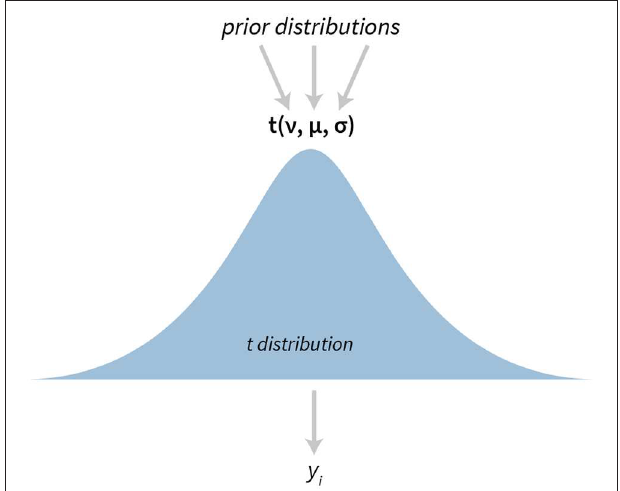
FIGURE 1 | The visualization of the Bayesian t -test. The model has three parameters—degrees of freedom ν , mean µ , and variance σ . y i denotes i -th datum in the provided data